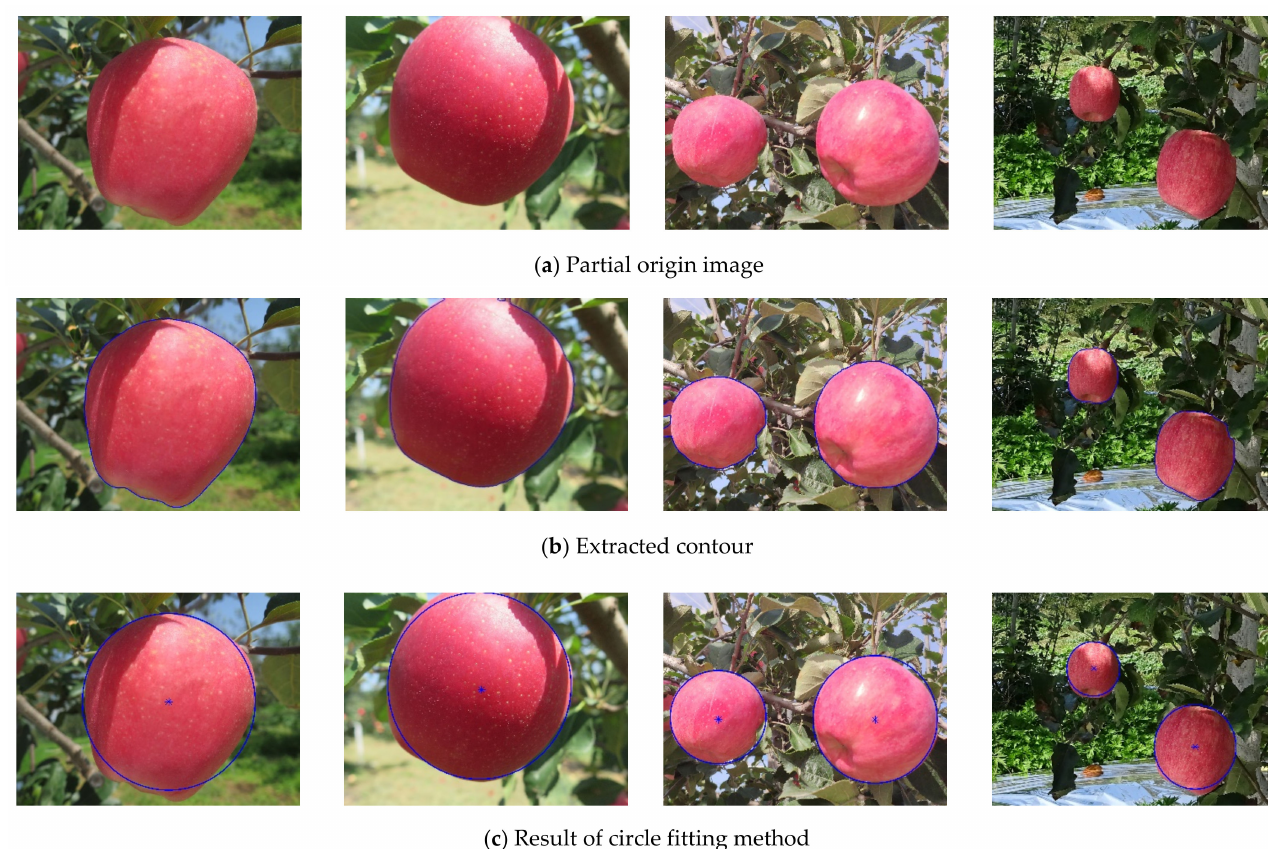
Figure 9. Localization process of apple targets based on circle fitting method: ( a ) Partial origin image, ( b ) Extraction of apple contours, ( c ) Final fitting